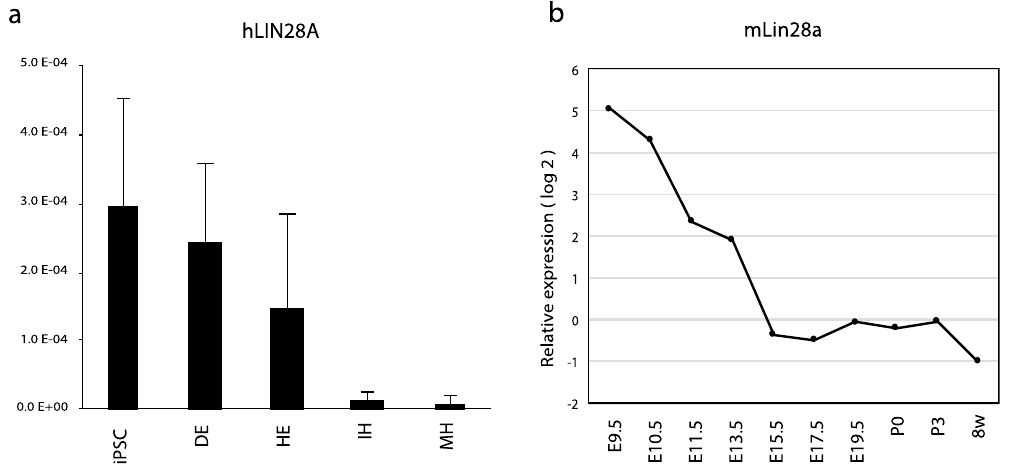
Figure 1. LIN28A is not suitable for detecting undifferentiated iPSC during hepatic differentiation. ( a ) Human LIN28A expression during hepatic differentiation from iPSC. DE, definitive endoderm; HE, hepatic endoderm; IH, immature hepatocyte; MH, mature hepatocyte. The relative expression levels were normalized by the amount of 18S rRNA in each sample. ( b ) Mouse Lin28a expression in hepatic cells during liver development. For samples from embryonic day 9.5 (E9.5) to post natal day 3 (P3) total RNA was isolated from nonhematopoietic (CD45 − TER119 − ) cells. For 8 week (8w) old sample, hepatic cell fraction was isolated by